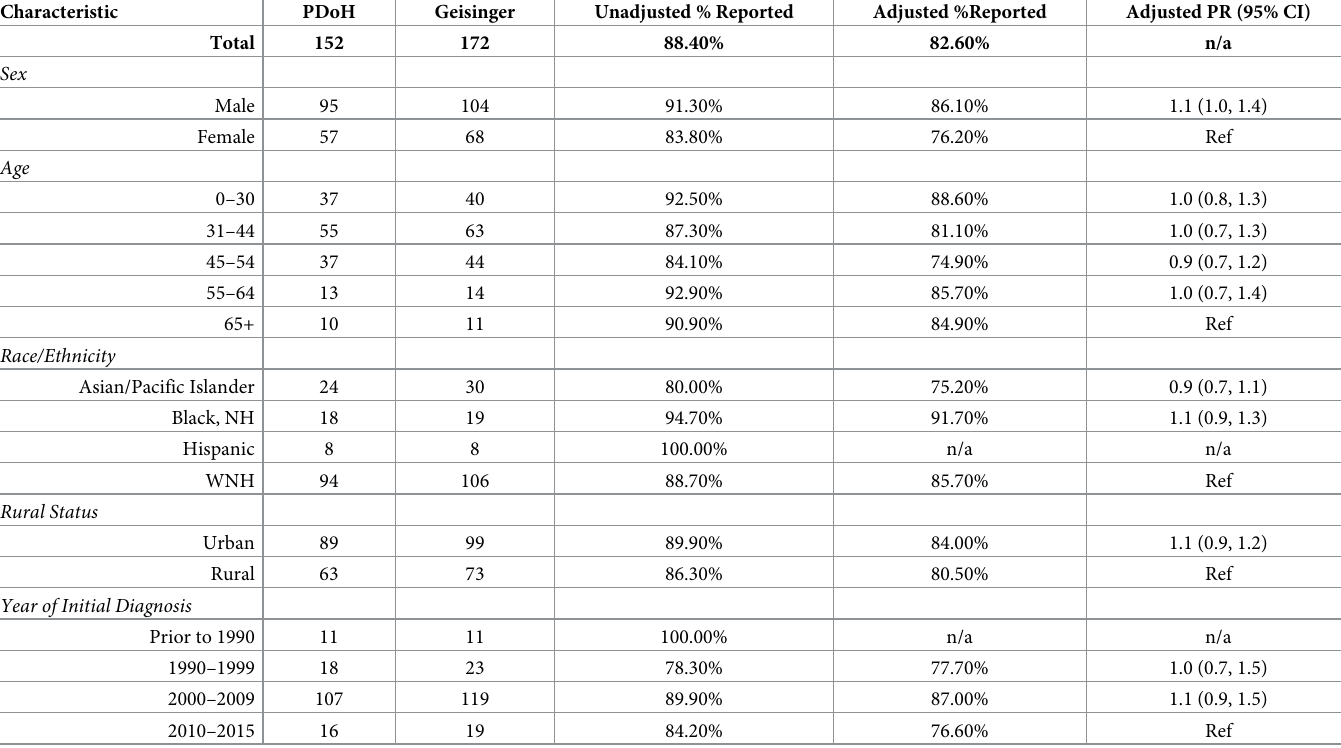
Table 1. Percentage of viral hepatitis B infections reported to the pennsylvania department of health, 2001–2015.